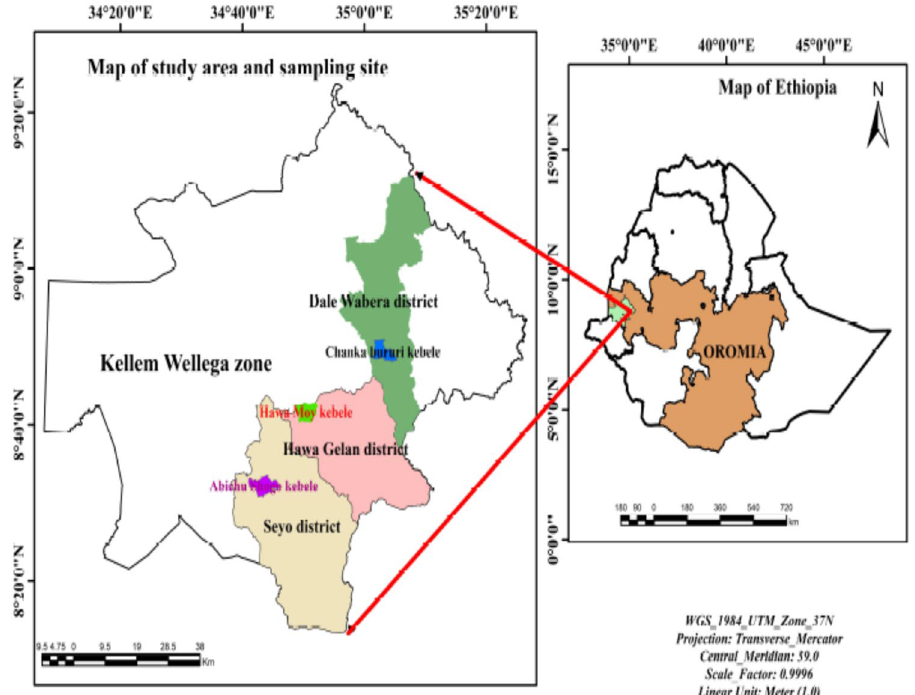
Figure 3. Map of the study area.